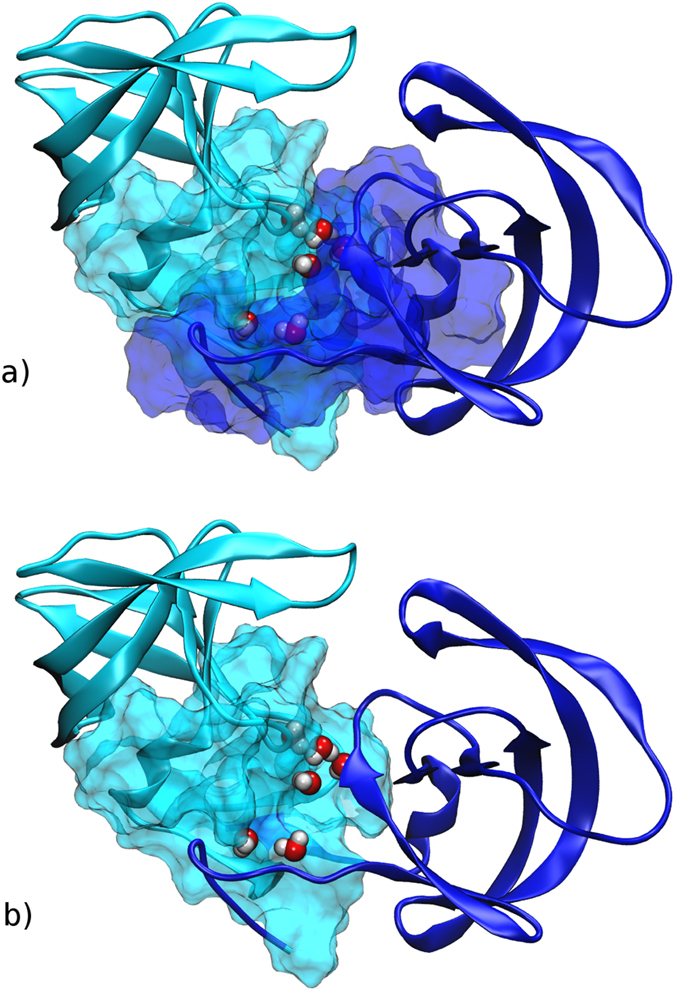
Example of dimer conformation in the transition region connecting the fully bound complex (state S1) with the partially open complex featuring the new binding pocket (state S2).Six water molecules are trapped at the dimer interface (dry in state S1), without contact with the bulk solvent. In (panel a) both monomers are represented in the same way, whereas in (panel b) the second one is shown only as a cartoon to allow a more direct view of water molecules.